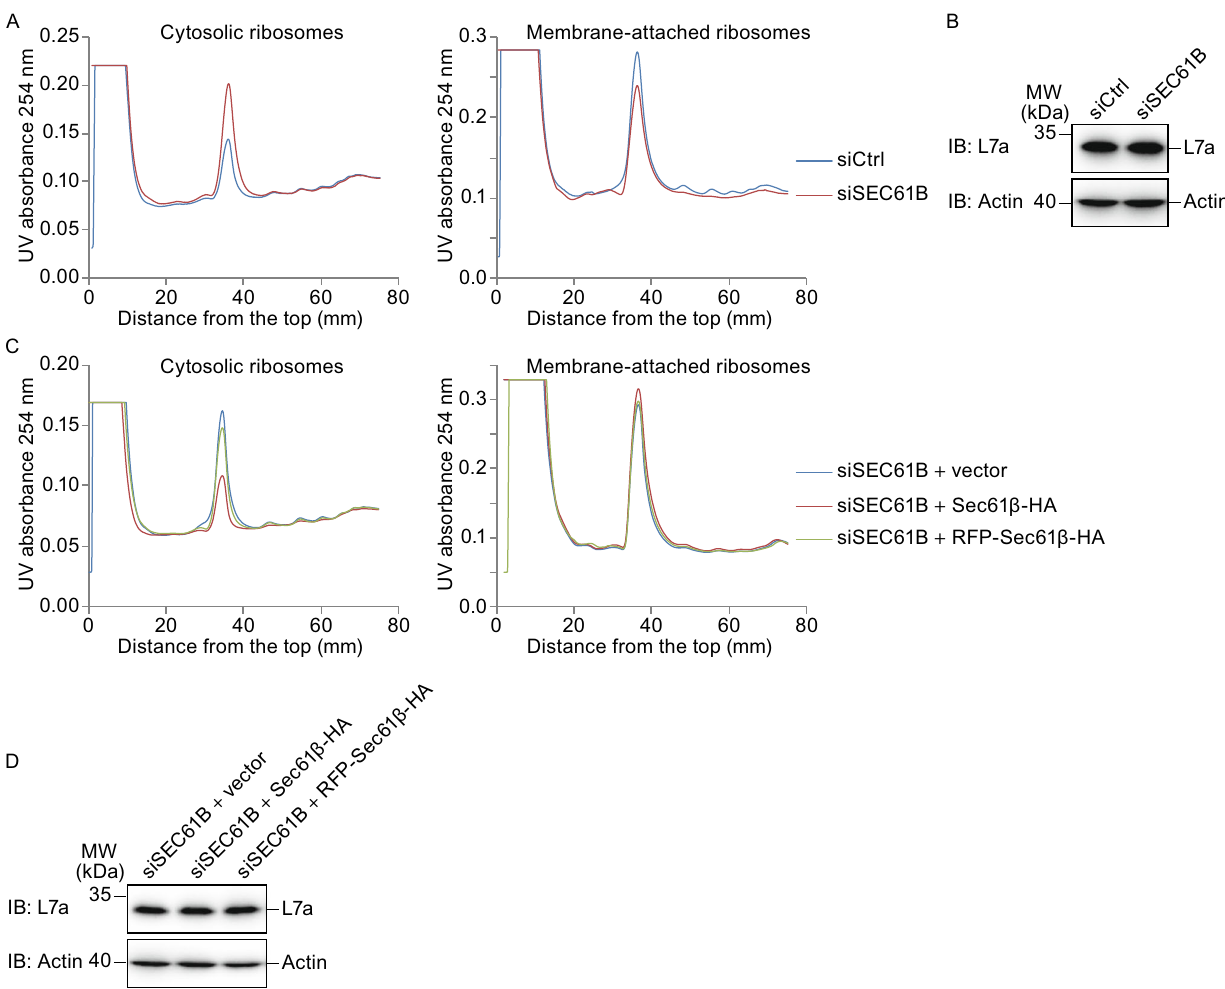
Figure 7. Sec61 β stabilizes membrane attachment of ribosomes. (A) Polysome pro fi les of U2OS cells transfected control siRNA (siCtrl) or siSEC61B#2. (B) Total lysates from (A) were analyzed by Western blotting, with actin as a loading control. (C) As in (A), but U2OS cells co-transfected siSEC61B#2 and indicated plasmids. (D) As in (B), but from cells in (C). For all of them, the trends are similar among at least two